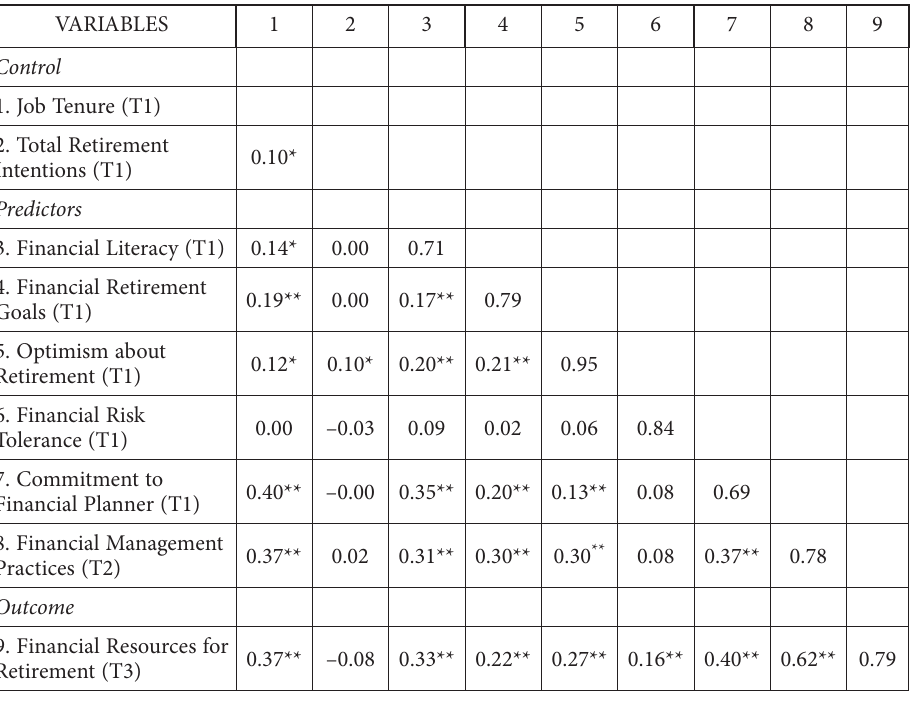
According to Table 2, the associations with a p < 0.01 are highlighted